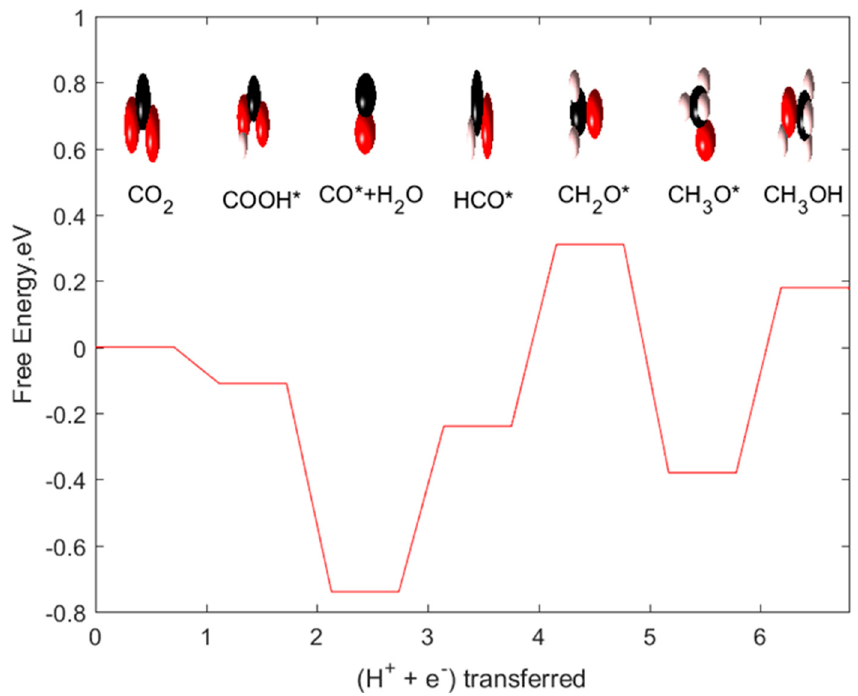
Figure 3. Lowest energy pathway of CO 2 reduction to CH 3 OH on the WC/graphene excluding solvation effect. Color code of atoms: red: oxygen, black: carbon, white: hydrogen.